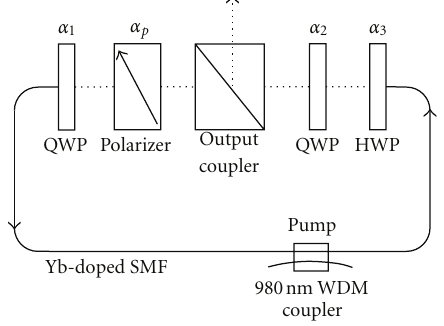
Figure 1: Experimental configuration of a ring laser cavity that in- cludes quarter-waveplates (QWP), passive polarizer, half-waveplate (HWP), ytterbium-doped amplification, and output coupler. The Yb-doped section of the fiber is fused with standard single-mode fiber and treated in a distributed fashion. The angles α 1 , α 2 , α 3 , and α p of the discrete mode-locking elements can all be measured with reasonable accuracy. The dotted lines denote free space (from